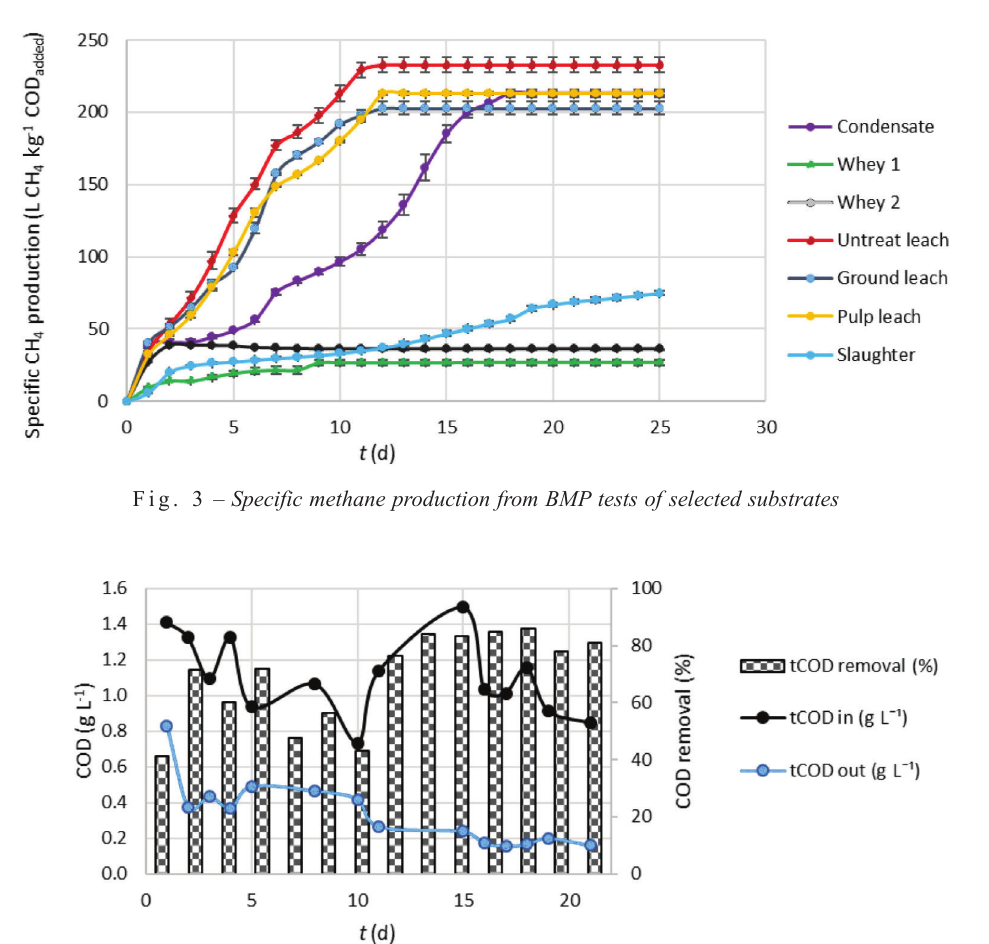
Fig. 3 – Specific methane production from BMP tests of selected